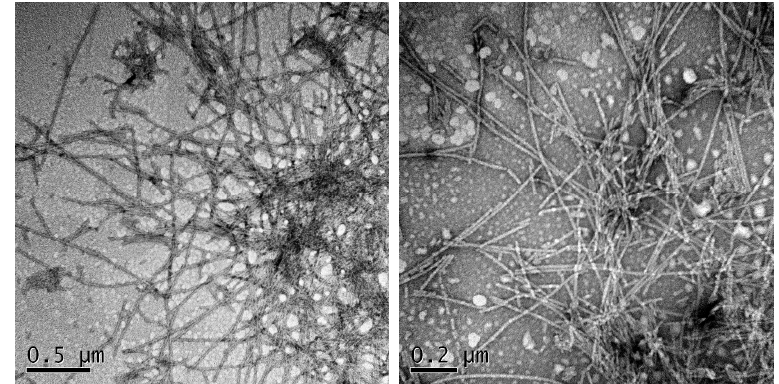
Figure 3. α -Synuclein fibrils formed in the presence of teflon beads. TEM images were collected upon incubation of 70 µ M soluble α -syn for 24 h with agitation in the presence of beads. The samples were briefly sonicated before imaging.